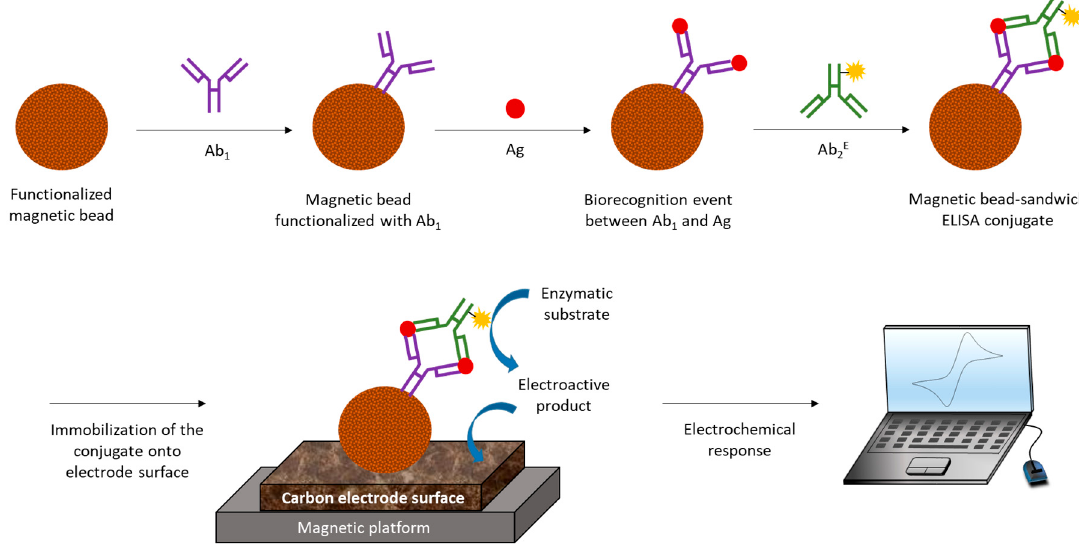
Figure 9. Schematic representation of typical EI fabrication steps using magnetic beads as surface material for immobilization of immunoreagents. The immunocomplex is composed of a primary antibody (Ab 1 ), analyte of interest or antigen (Ag) and a secondary antibody (Ab 2 ) labelled with a redox enzyme (E). The magnetic bead-sandwich ELISA conjugate is attached to the carbon electrode surface using a magnetic platform for electrochemical measurements in order to detect antigens of interest [134].